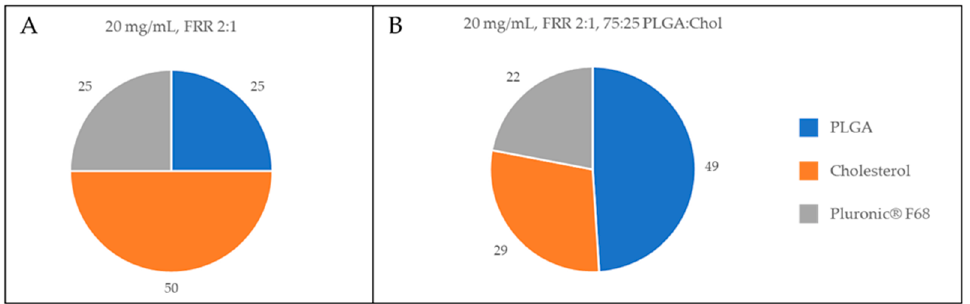
Figure 2. Graphical representation of the composition of H-NMeds. Blue: PLGA content. Orange: Cholesterol content (CC %). Grey: Pluronic ® F68 content. ( A ) H-NMeds obtained with the microfluidic device at a concentration of 20 mg/mL and an FRR of 2:1. ( B ) H-NMeds obtained with microfluidic-based protocols using a ratio of PLGA:Chol of 75:25, using an initial concentration of 20 mg/mL, and an FRR of 2:1.